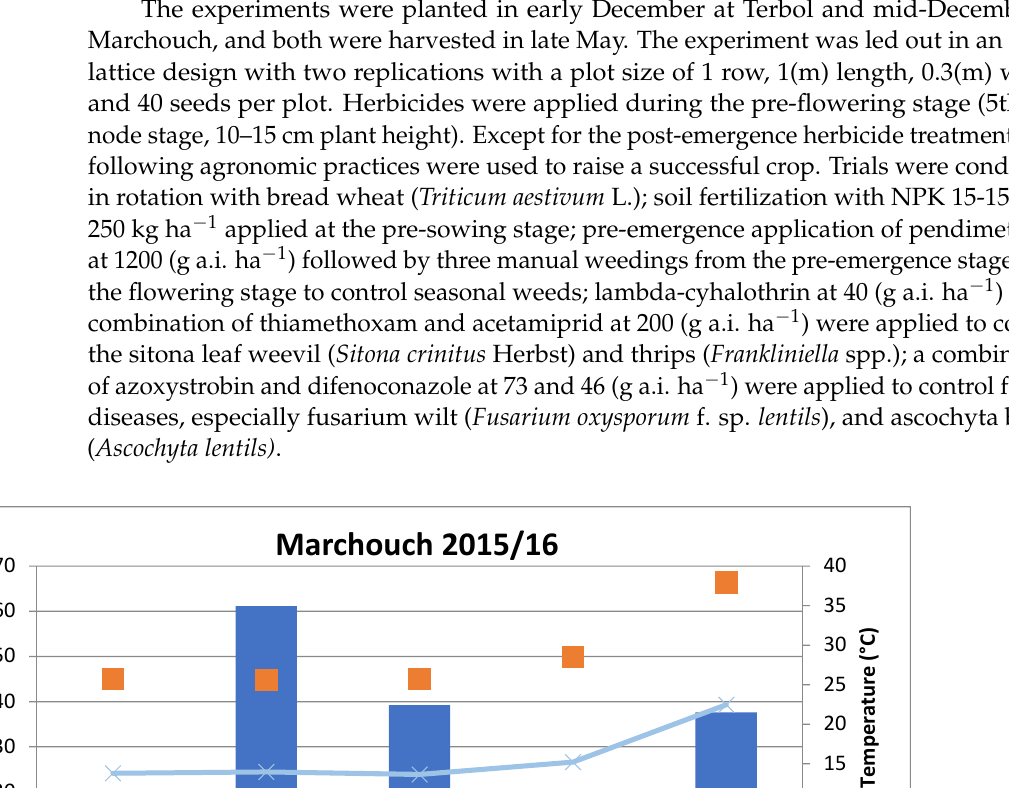
Table 7. Specifications and details of the various environments tested for lentil screening.